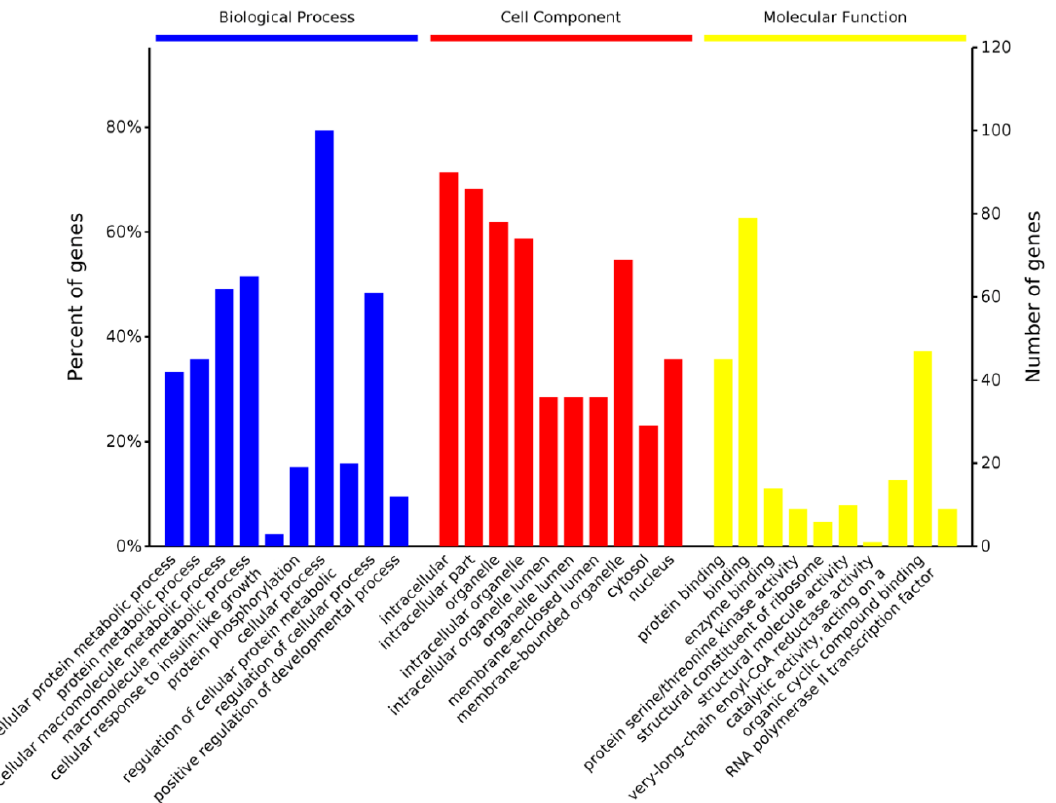
Molecules 2022 , 27 , x FOR PEER REVIEW Figure 6. GO is annotation of identified in SW1990 cells treatment with G-6 10 µM for 24 h proteins in three categories: biological process (BP), cellular component (CC) and molecular function (MF).